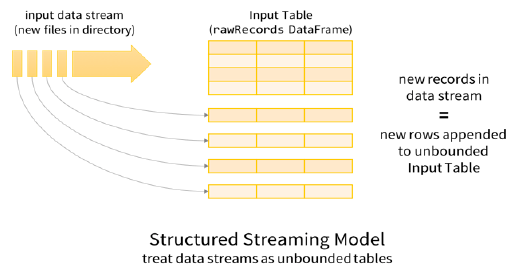
Figure 2. Structured Streaming Model [25].